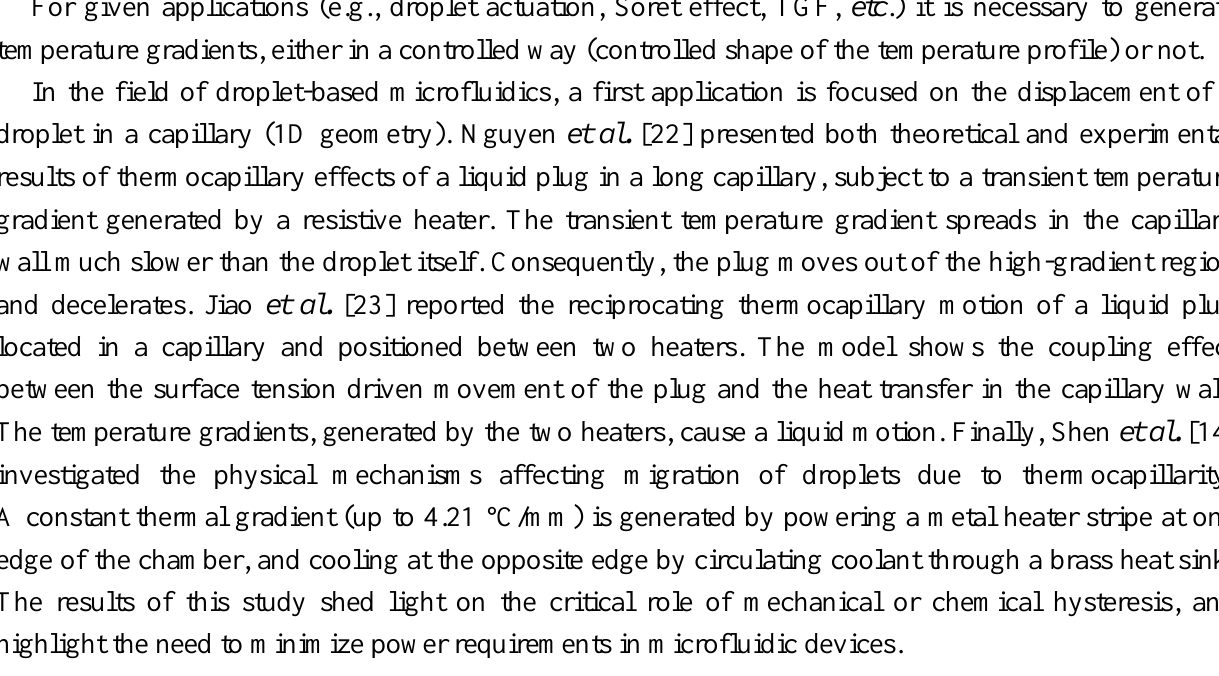
Figure 16. ( a ) A schematic view of the microfluidic device (dimensions in µm). ( b ) Variation of the delay distance d with temperature. Reprinted with permission from